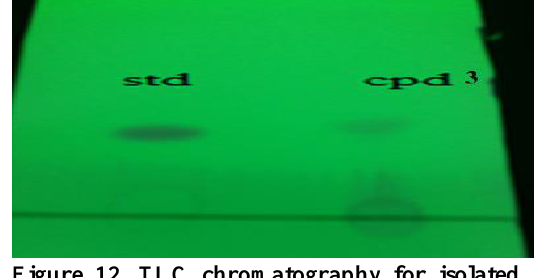
Figure 12. TLC chromatography for isolatede compound number (3) from ethyl acetate fraction and caffeic acidi standard using silica gel Gf254 as adsorbant and mobile phase S2 .